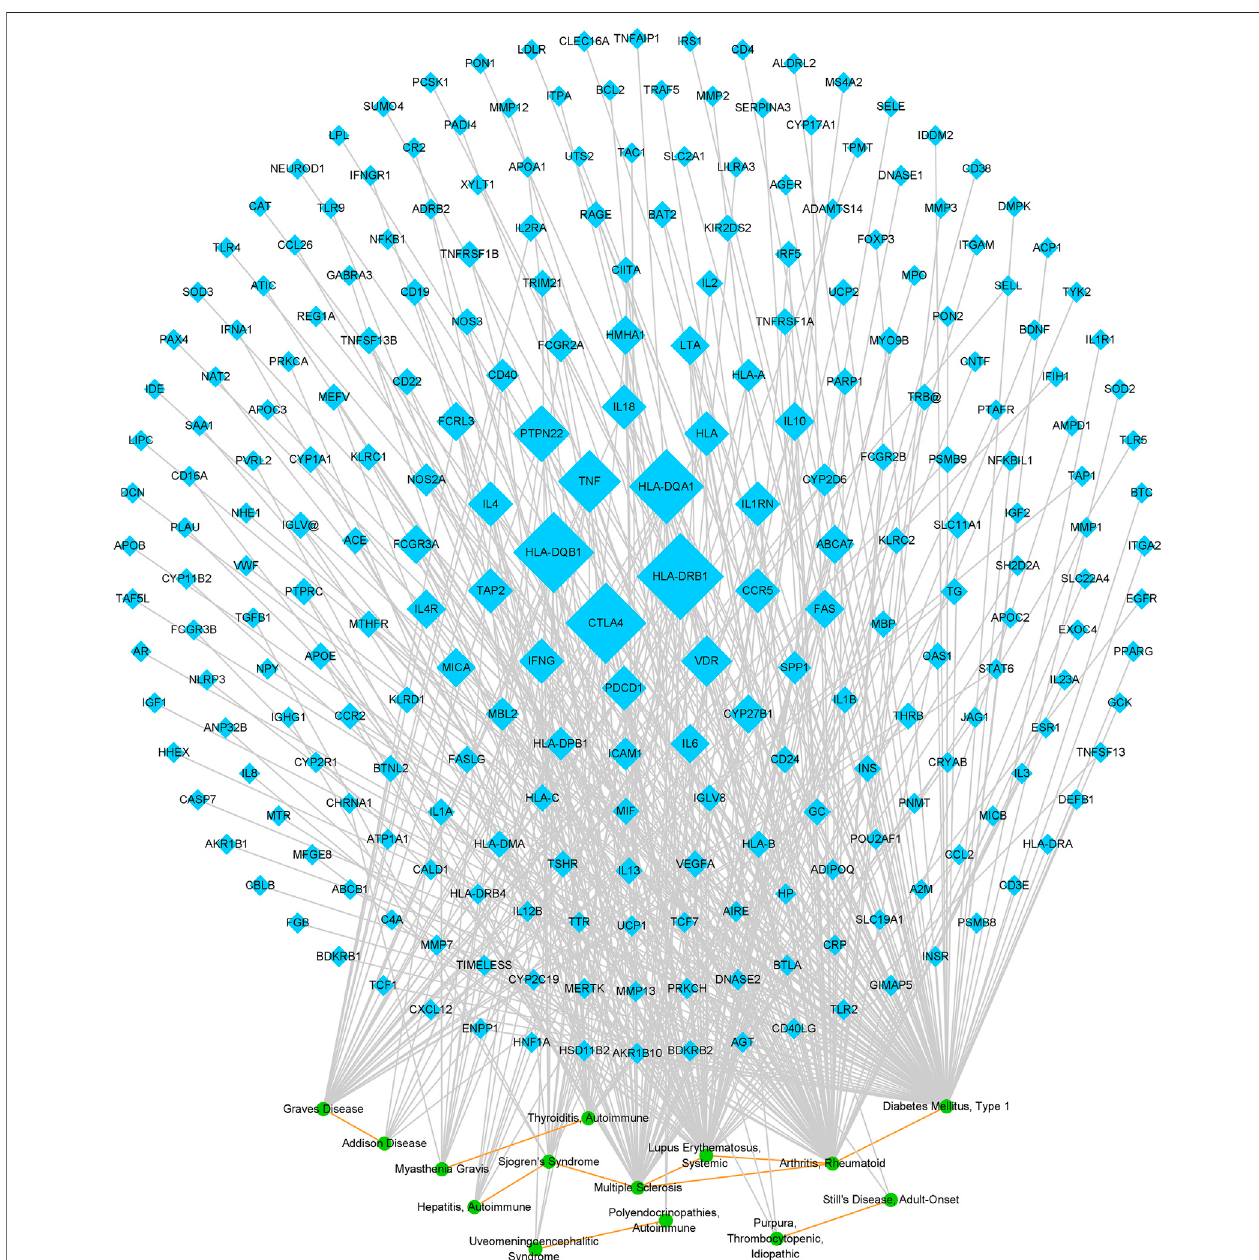
FIGURE3| Networkon potentialpairs ofsimilarADsand AD-generelationships. Theblue nodes representgenes, and thesize ofthese nodes corresponds tothe node degree. The green nodes represent ADs. The gray edges represent disease-gene relationships, and the orange edges represent potential AD similarity